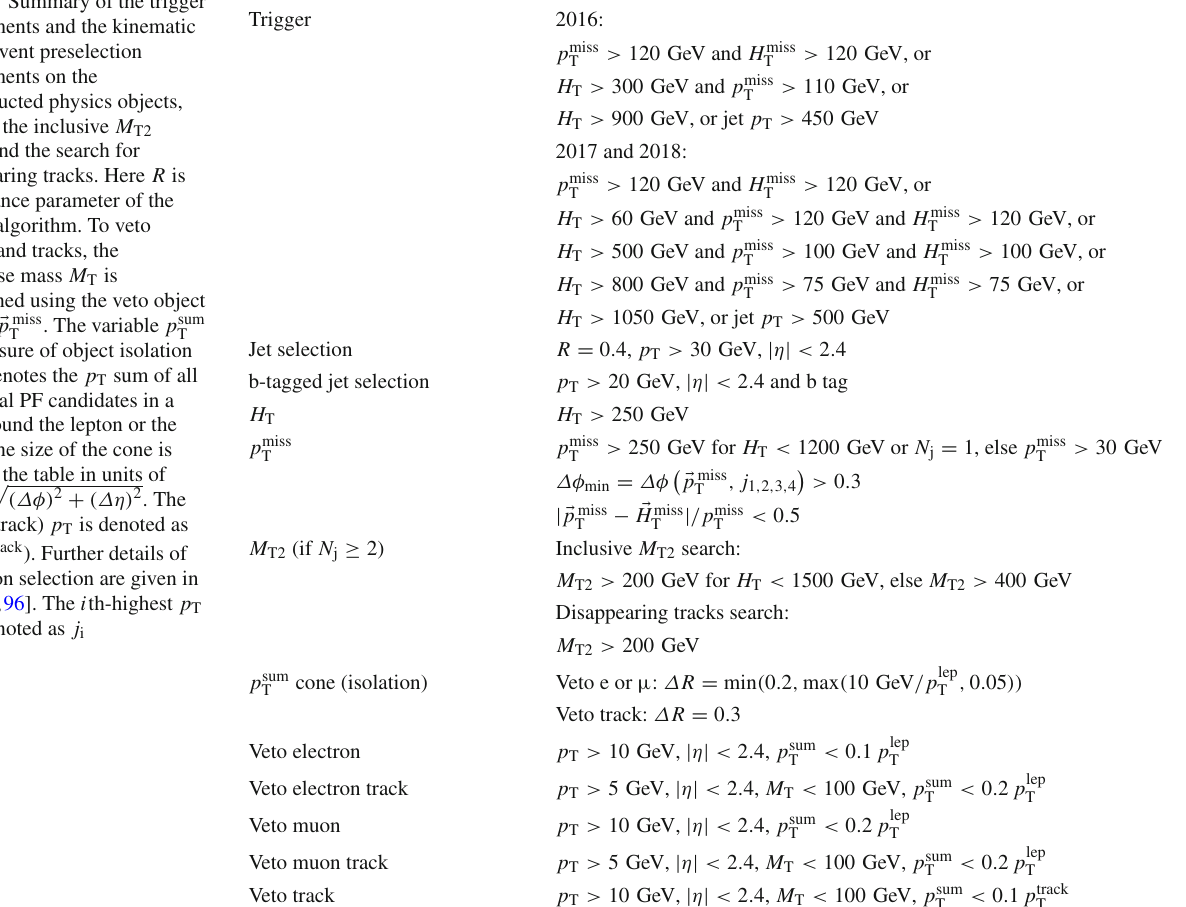
Table 1 Summary of the trigger requirements and the kinematic offline event preselection requirements on the reconstructed physics objects, for both the inclusive M T2 search and the search for disappearing tracks. Here R is the distance parameter of the anti- k T algorithm. To veto leptons and tracks, the transverse mass M T is determined using the veto object and the (cid:4) p miss . The variable p sum T T is a measure of object isolation and it denotes the p T sum of all additional PF candidates in a cone around the lepton or the track. The size of the cone is listed in the table in units of √ Δ R ≡ (Δφ) 2 + (Δη) 2 . The lepton (track) p T is denoted as p lep ( p track ). Further details of T T the lepton selection are given in Refs. [9,96]. The i th-highest p T jet is denoted as j